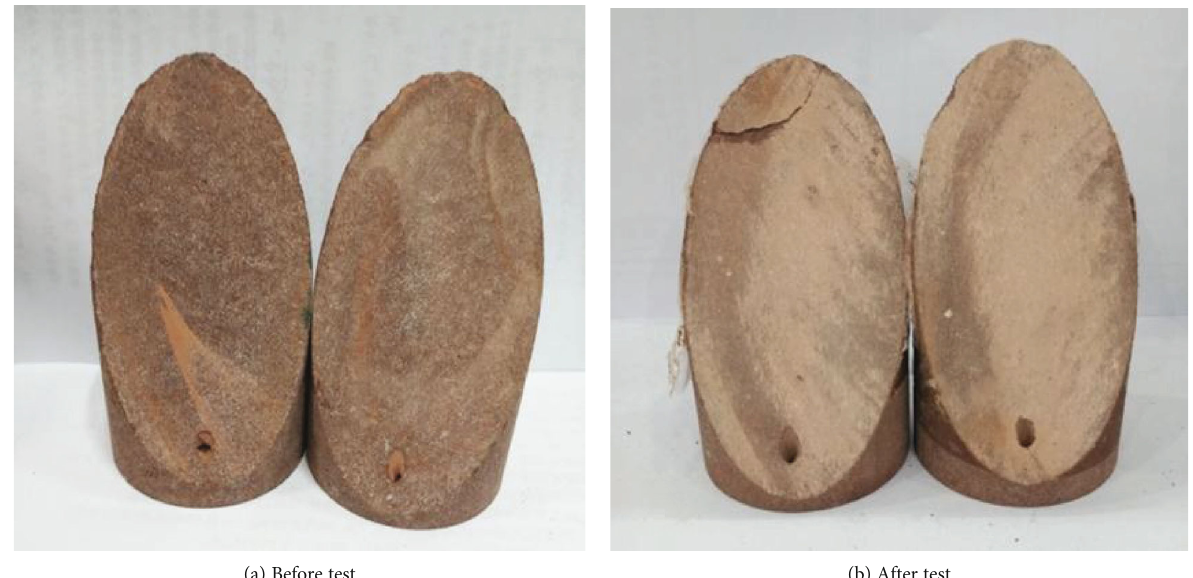
Figure 6: Comparison of untested fracture surfaces and tested fracture surfaces of